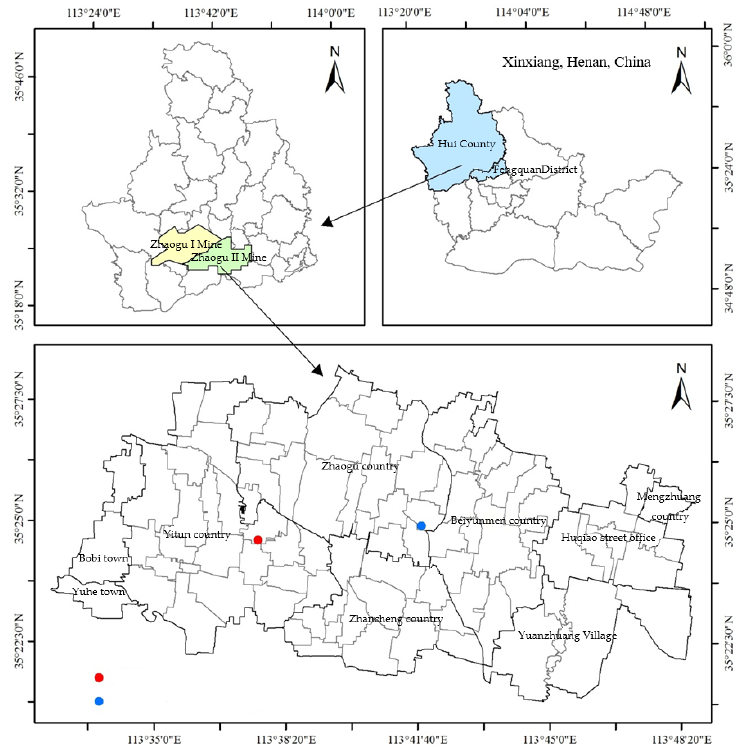
Figure 1. Geographical location map of the study area.